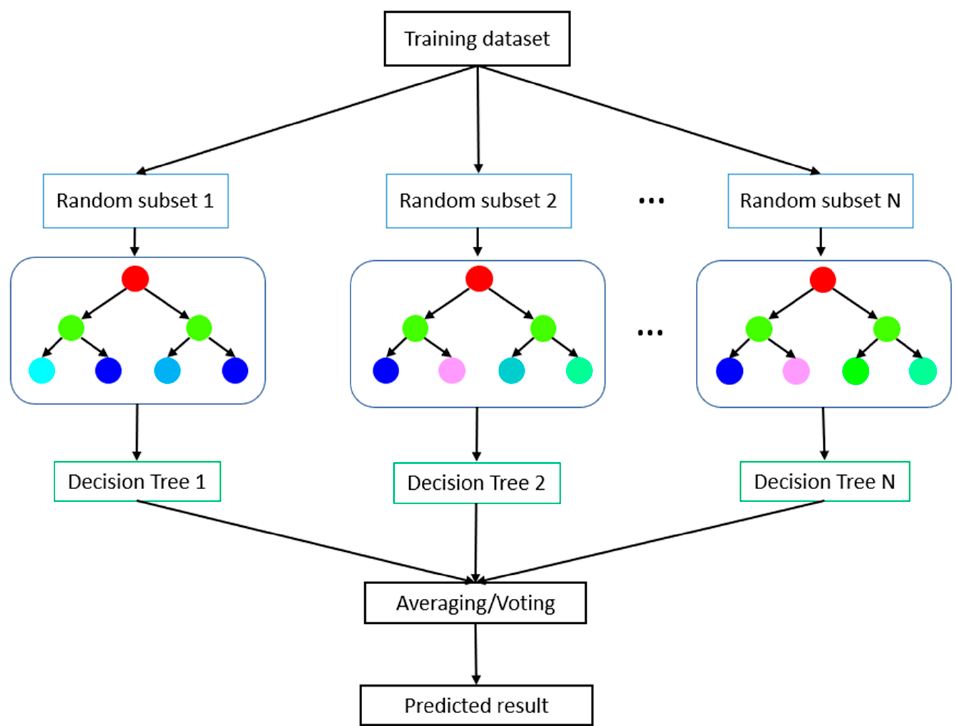
Figure 3. A general random forest model.